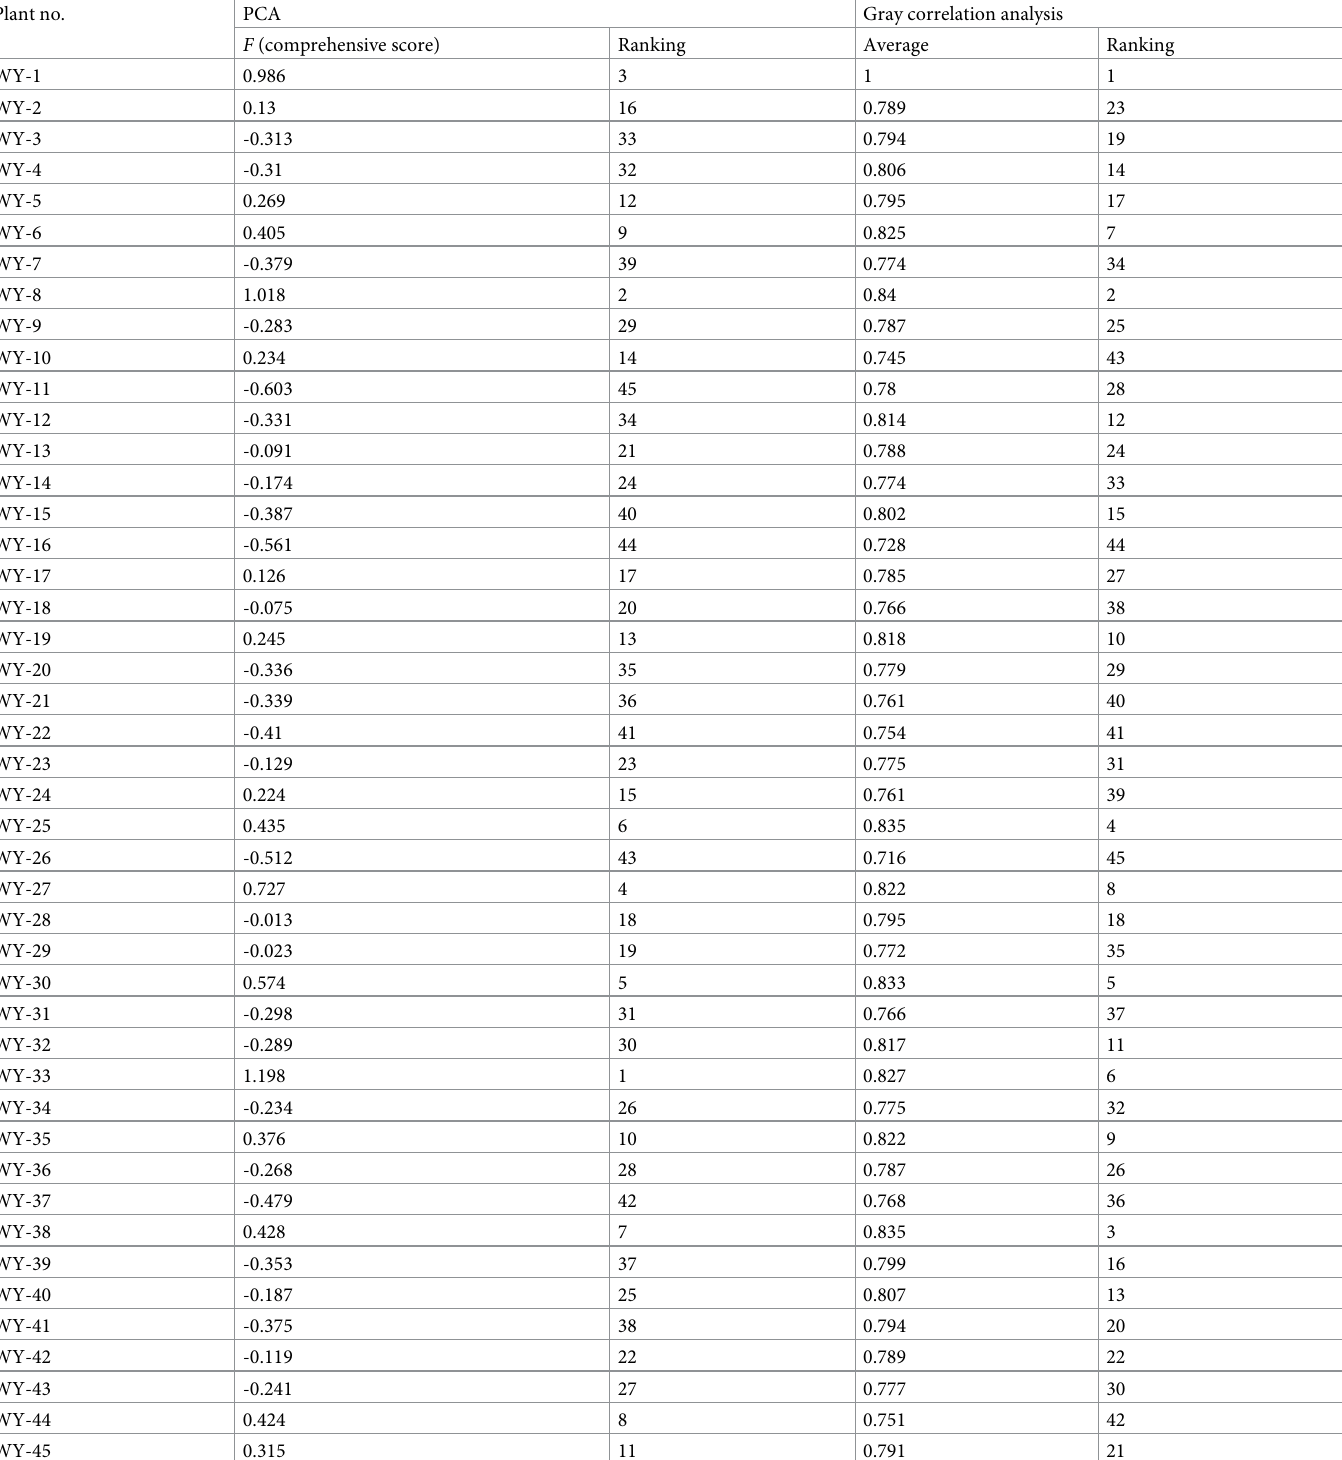
Table 4. Comprehensive evaluation scores of the 45 C . weiningensis plants and their rankings based on the two analytical methods. Plant no. PCA Gray correlation analysis F (comprehensive score) Ranking Average